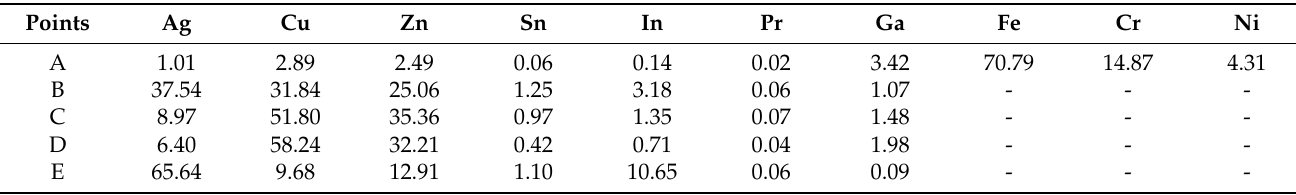
Figure 9. SEM images of microstructures around the interface between 12AgCuZnSn-2In-0.15Pr- x Ga filler metals and 304 stainless steel (“ x ”: the mass fraction of Ga): ( a ) x = 0, ( b ) x = 0.5, ( c ) x = 1, Table 3. EDS analysis of the points indicated in Figure 9